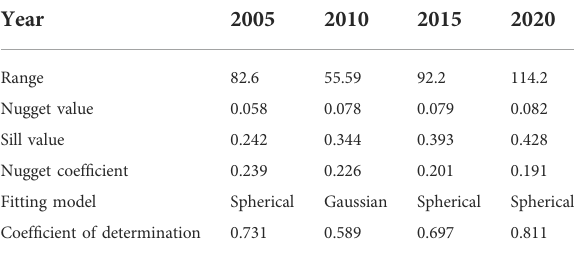
TABLE 1 Parameters of the variogram model on the spatial pattern of county economy in Hubei province.